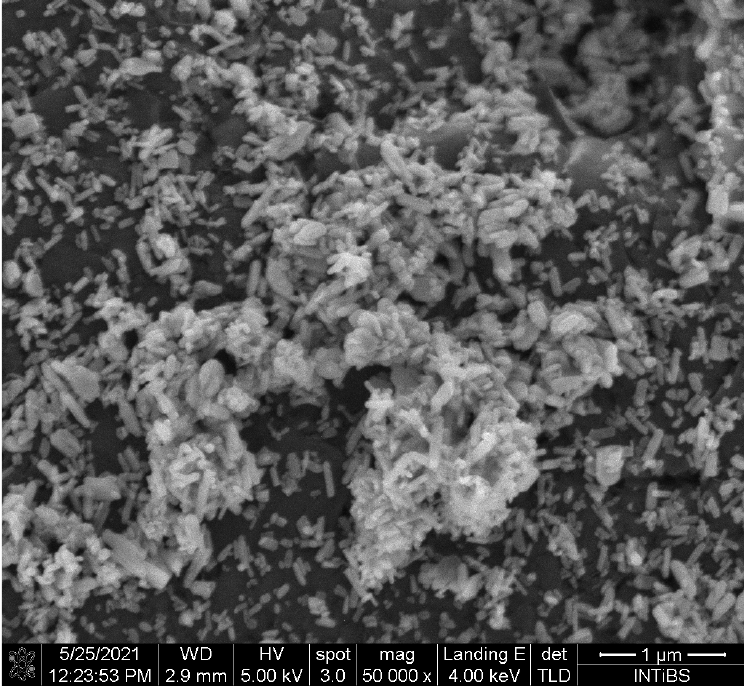
Figure 2. Scanning electron microscope (SEM) image of nanosized fluorapatite. Table 1. Atomic parameters of the Ca 10 (PO 4 ) 6 F 2.